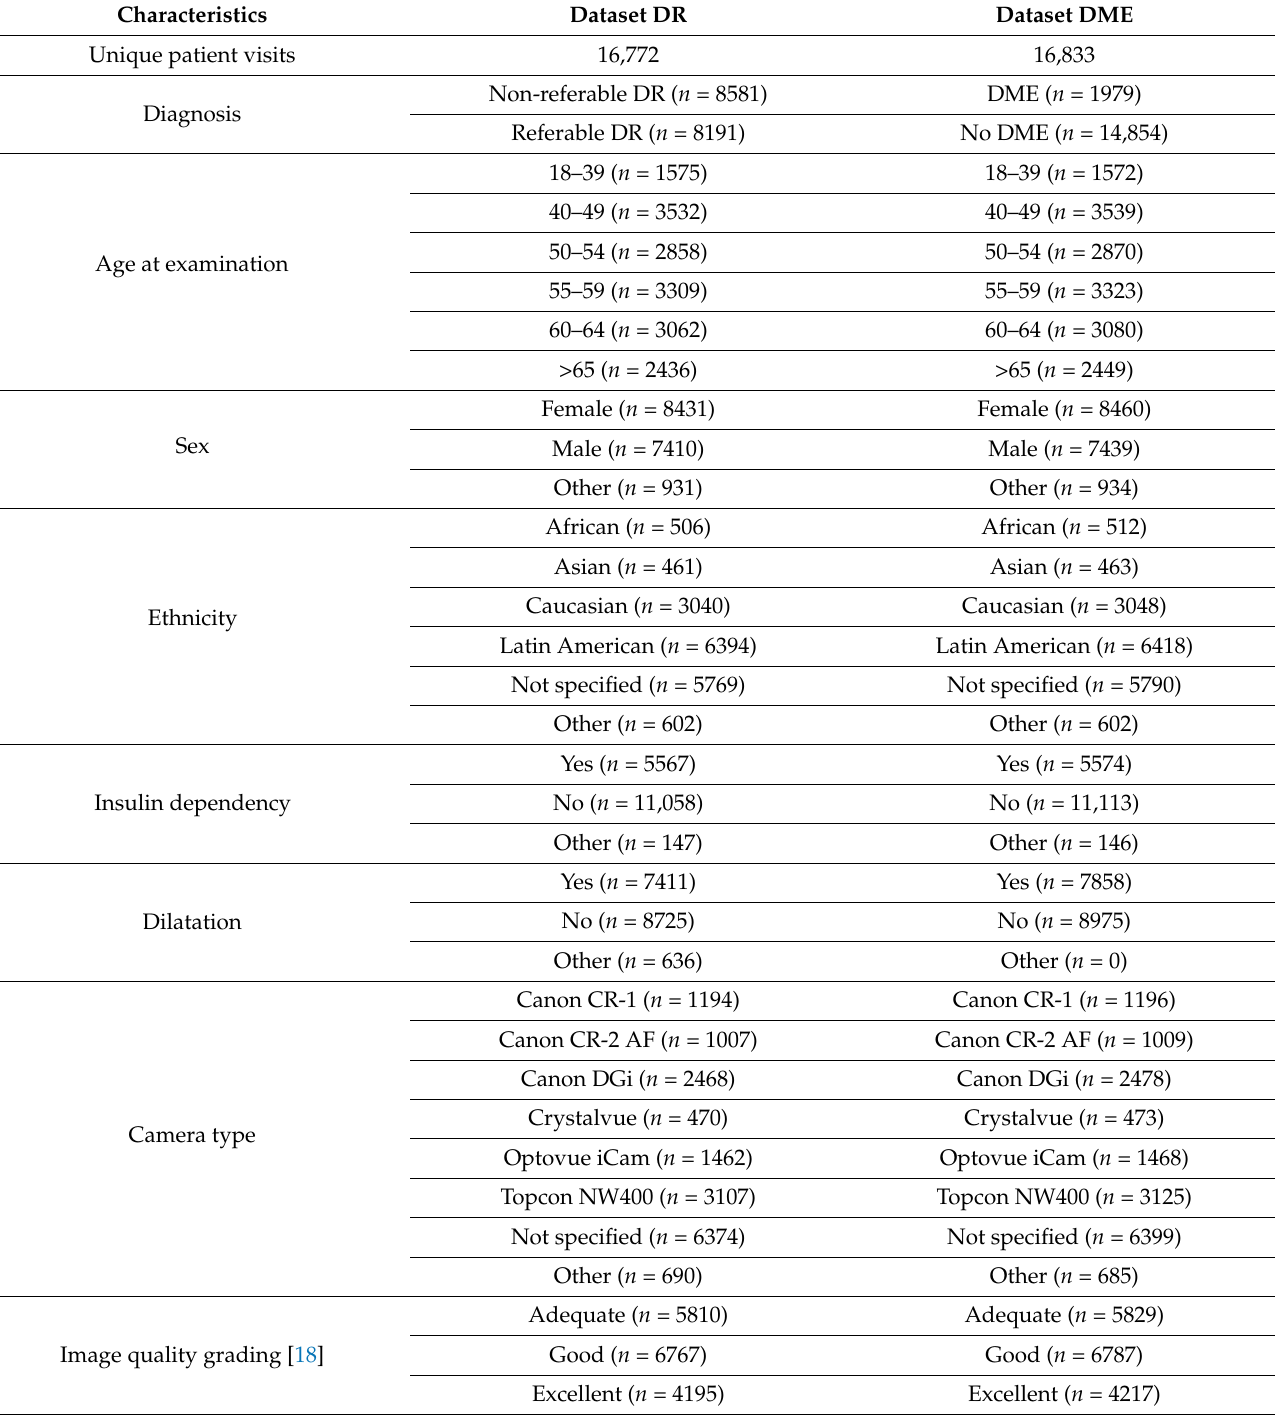
Table 1. An overview of the study population. The category other consists of invalid values, errors, impossible values,